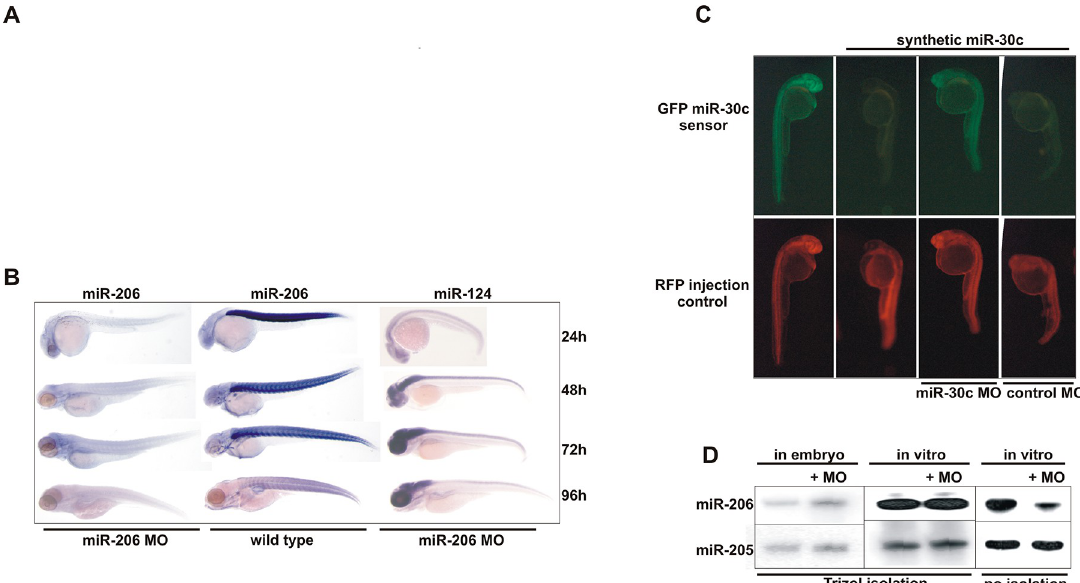
Fig 1. Morpholinos Targeting the Mature miRNA Deplete the Zebrafish Embryo of Specific miRNAs. (A) Removed panel previously showing Northern blot for miR-206 in wild-type and MO miR-206–injected embryos at 24, 48, and 72 hpf. (B) In situ analysis of miR-206 and miR-124 expression in different stage embryos after injection of MO miR-206. (C) Effect of a morpholino targeting miR-30c on a silencing assay with miR-30c and a responsive GFP sensor construct. (D) In vivo and in vitro effects of a morpholino on the stability and RNA extraction of a synthetic miR-206 duplex. miR-205 serves as a loading